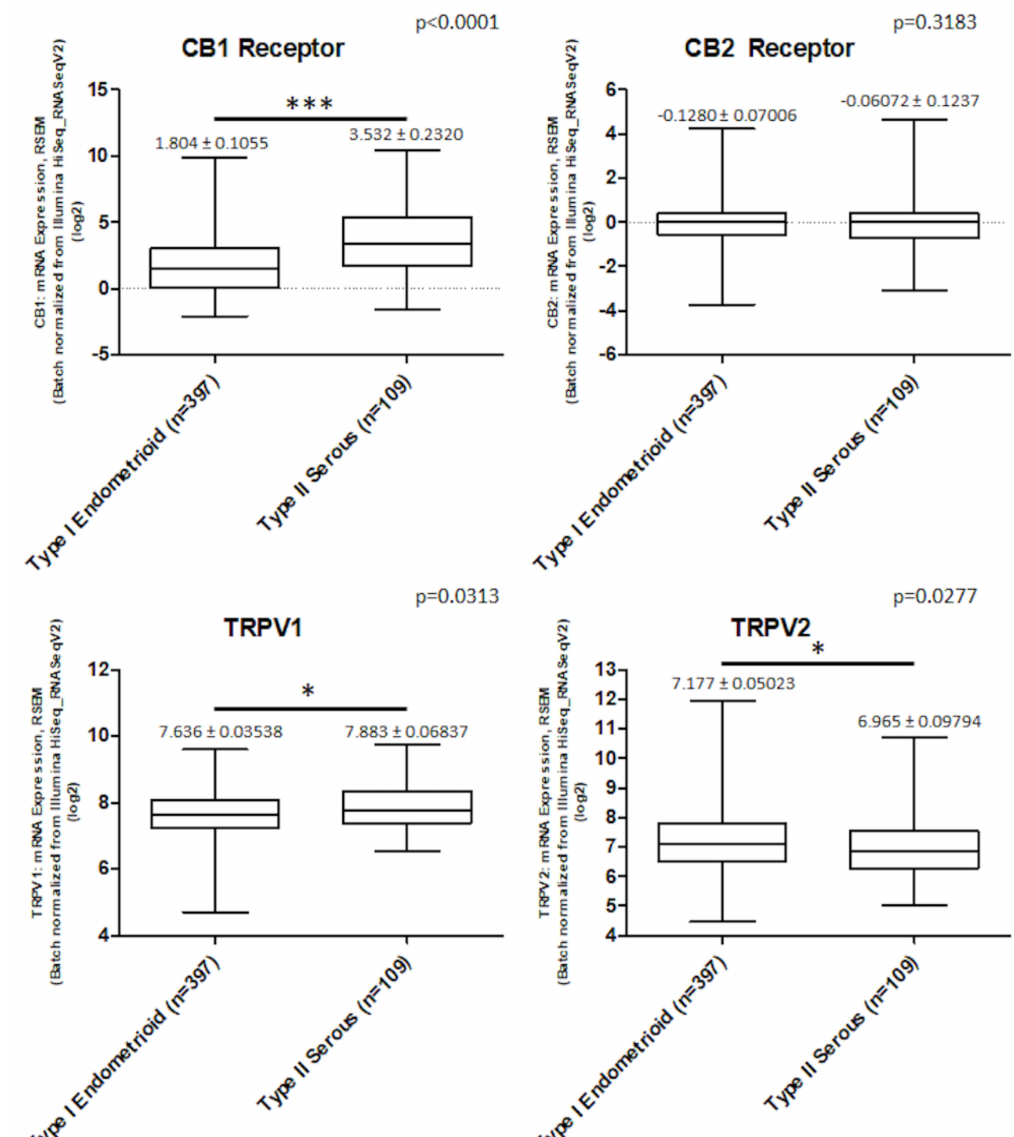
Figure 1. The expression of CBD (cannabidiol) targets in EC (endometrial cancer) patients. The mRNA expression (log RNA Seq V2 RSEM) of CB1 , CB2 , TRPV1 and TRPV2 in 506 EC samples, divided in 397 for type I and 109 for type II, from TCGA database. *** p < 0.001 type II vs. type I, * p < 0.05 type II vs. type